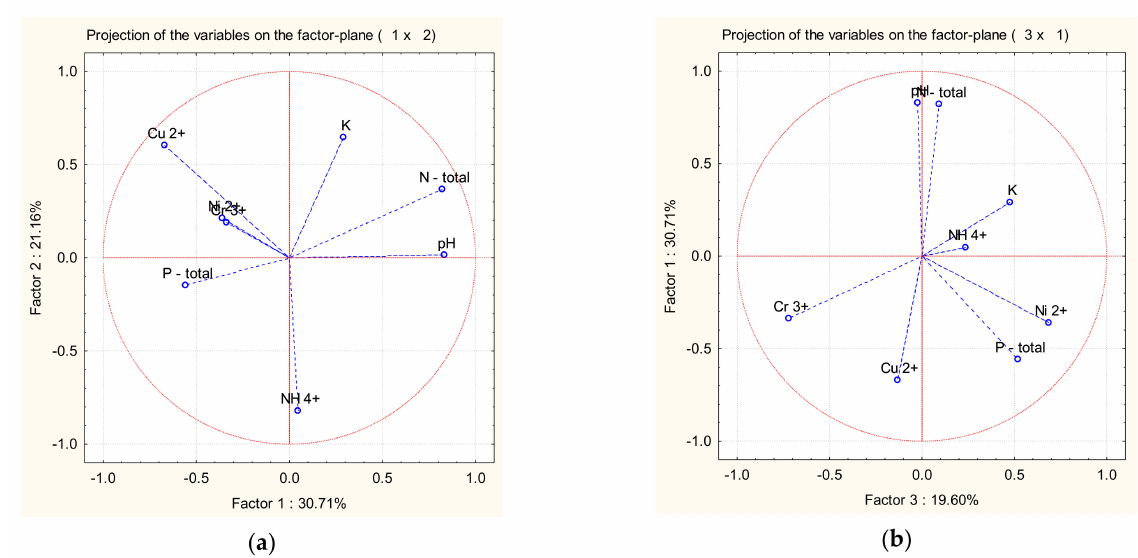
Figure 6. Non-supervised principal component analysis. (PCA) analysis representation of the relation between the metals and nutrients present in agricultural soils: ( a ) correlation F1–F2; ( b ) correlation F3–F1. The matrix scatterplots illustrating the relationship between heavy metals may be seen in Figure 7, together with the corresponding Pearson correlation coefficient. Correlation coefficients are close to 1 only for pH related to N–total, and for N–total related with K (the green cells in Table 5). Table 5 shows that the best correlation.